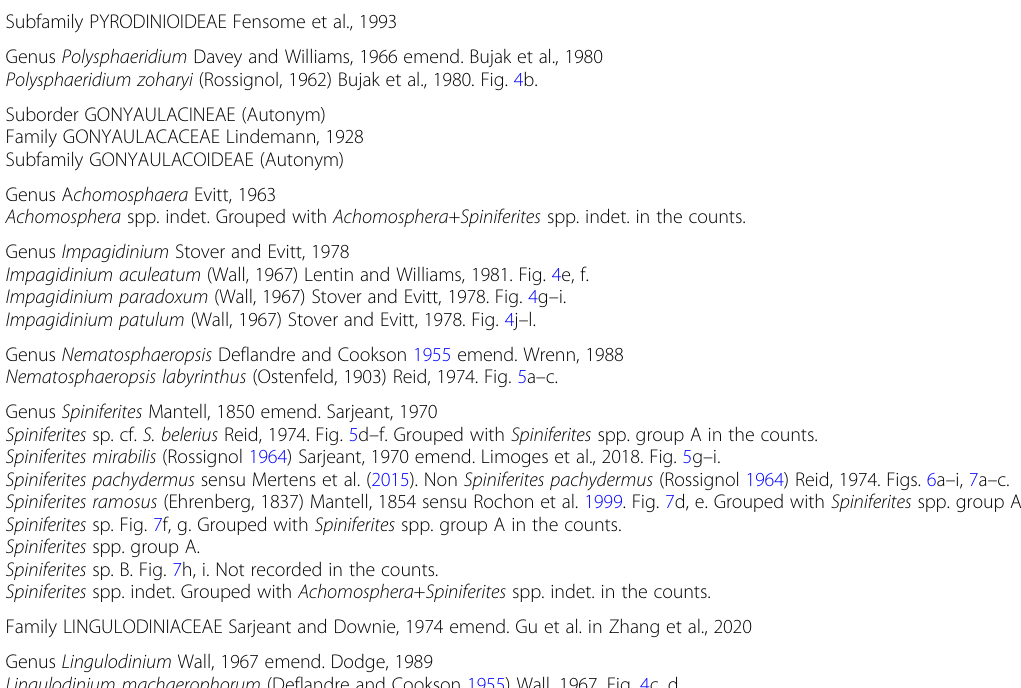
Table 1 Dinoflagellate cyst and acritarch taxa recorded in the present study, and their classification and authorial attributions. All taxa are considered in situ with the exception of the genus Cleistosphaeridium which is presumed reworked Subclass PERIDINIPHYCIDAE Fensome et al., 1993 Order GONYAULACALES Taylor, 1980 Suborder GONIODOMINEAE Fensome et al., 1993 Family PYROPHACACEAE Lindemann, 1928 Subfamily HELGOLANDINIOIDEAE Fensome et al., 1993 Genus Tuberculodinium Wall, 1967 Tuberculodinium vancampoae (Rossignol, 1962) Wall, 1967. Fig. 4a. Subfamily PYRODINIOIDEAE Fensome et al.,